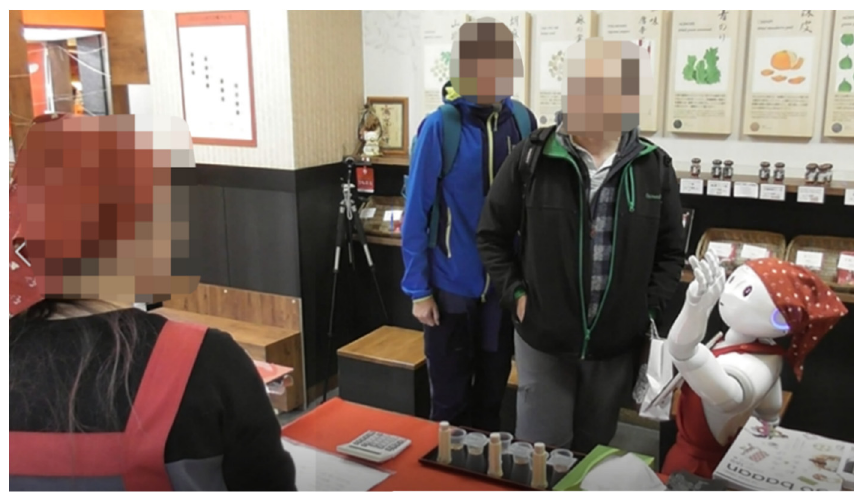
Figure 9. Robot’s movement to ask for a salesperson’s help.